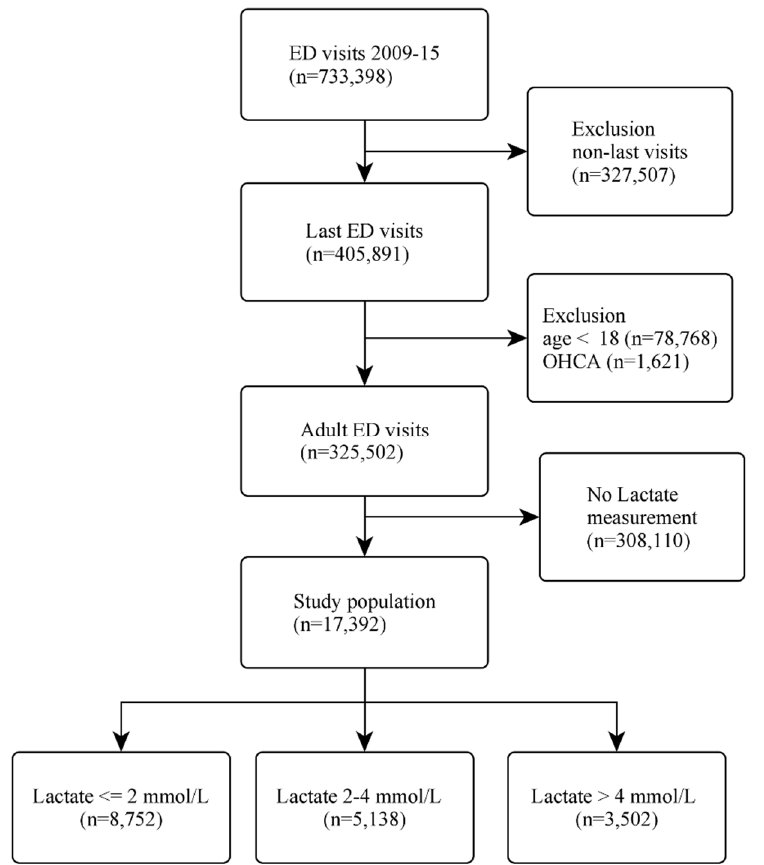
Figure 1. Flow diagram of the patient selection process. Abbreviations: ED, emergency department; OHCA, out-of-hospital cardiac arrest.